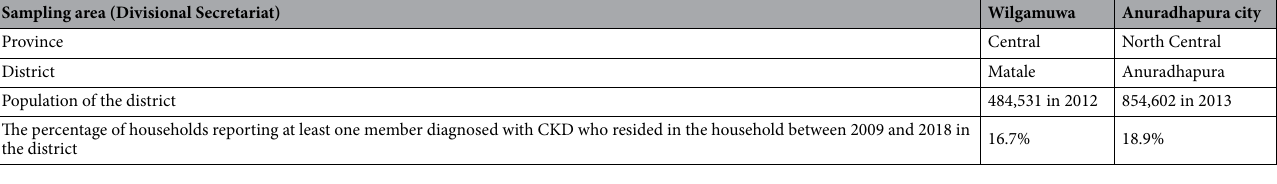
Table 4. The geographic data of the sampling area in this